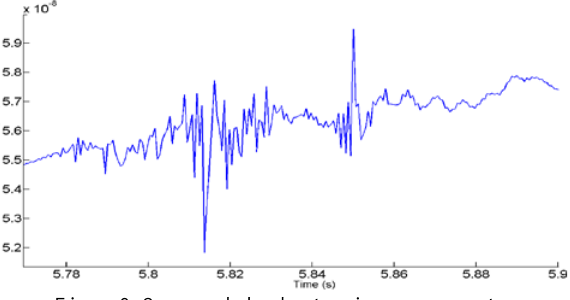
Figure 11. Evaluation of simulated motion blur with